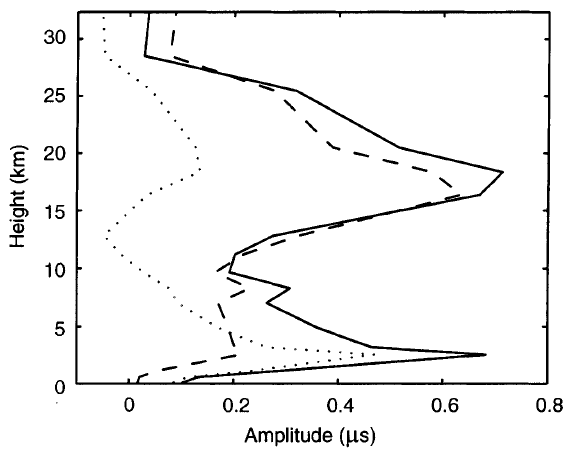
Fig. 2. Vertical distribution of contributions to the global AAM trend. Northern hemisphere ( dashed ), southern hemisphere ( points ) and sum of both contributions ( solid ). The ordinate is height in kilometers (km). Values are given in units of 10 ) 6 s (us)